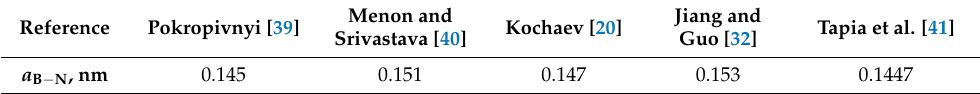
Figure 1. The scheme of an unrolled hexagonal boron nitride sheet with the definition of the chiral vector, C h , and the chiral angle, θ . Table 1. Values of the B–N covalent bond length available in the literature.